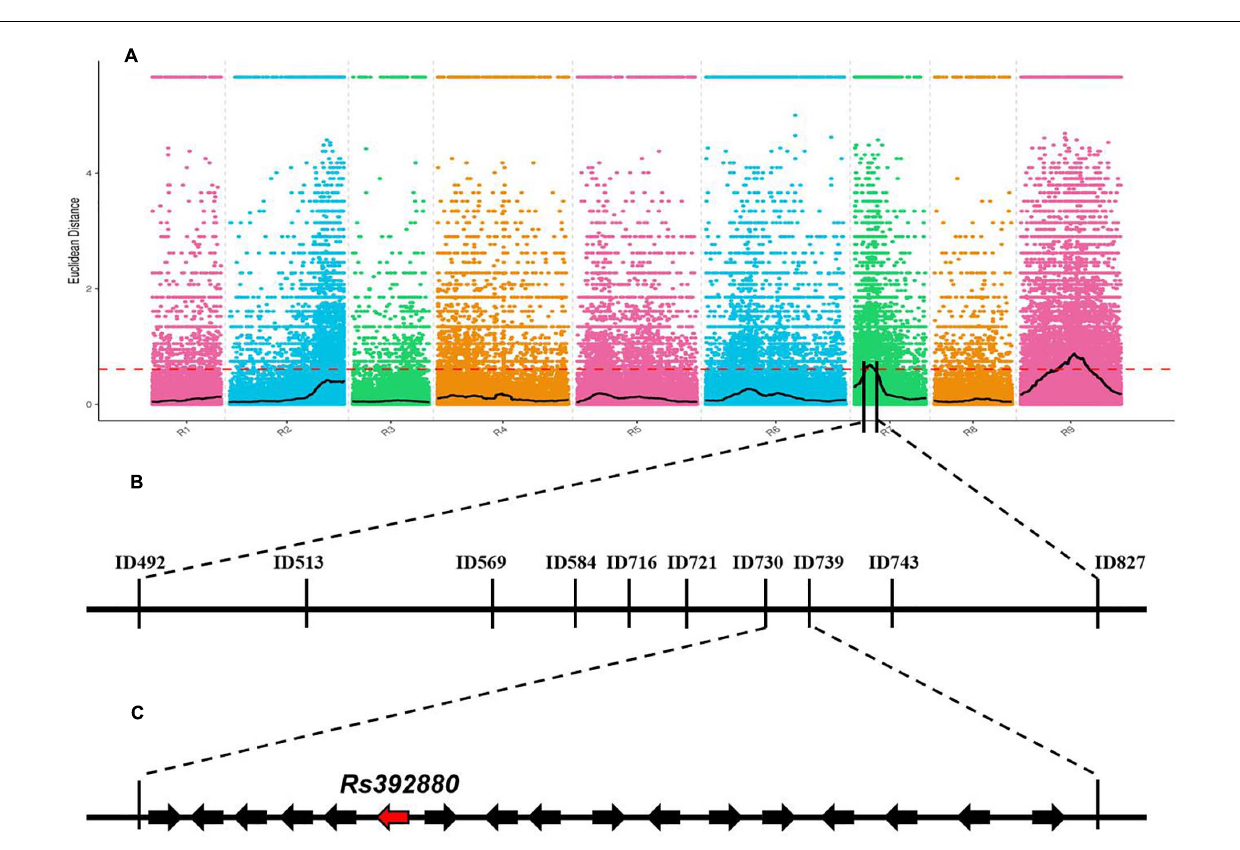
reference genome sequence 1 by BWA (Li and Durbin,